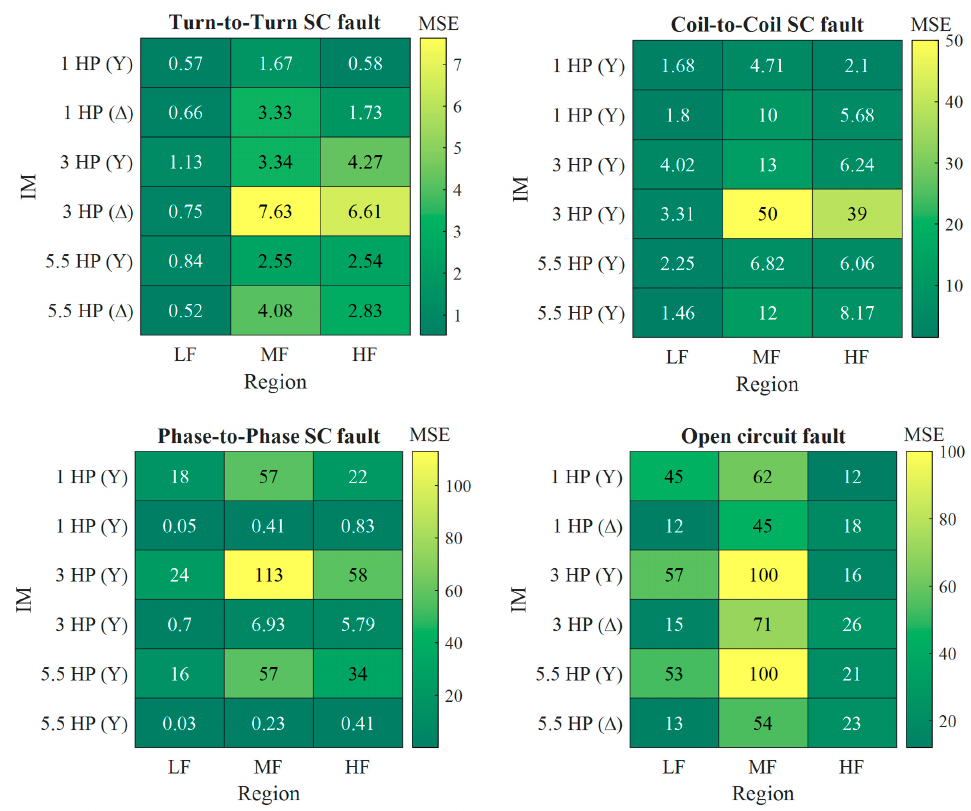
Figure 12. MSE calculated values between normal and other